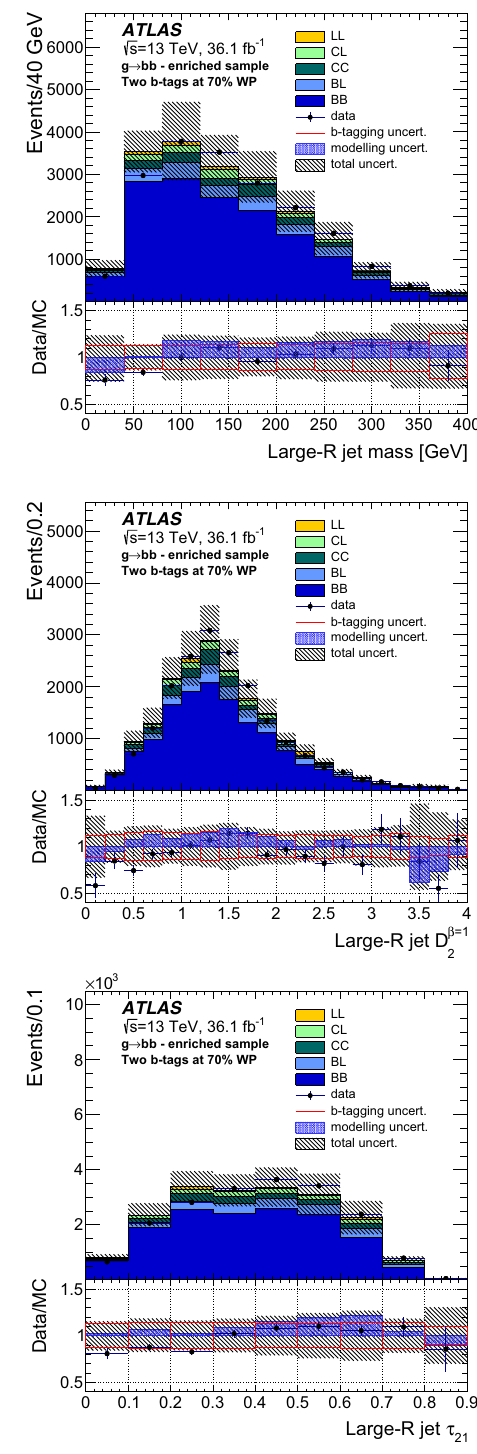
Fig. 17 Distributions of large- R jet mass (top), D (bottom) before (left) and after (right) double b -tagging. The flavour- tagging correction factors and the flavour-fit corrections have been applied. The two largest systematic uncertainties, generator modelling and the b -tagging-related uncertainties, are shown as well. The total